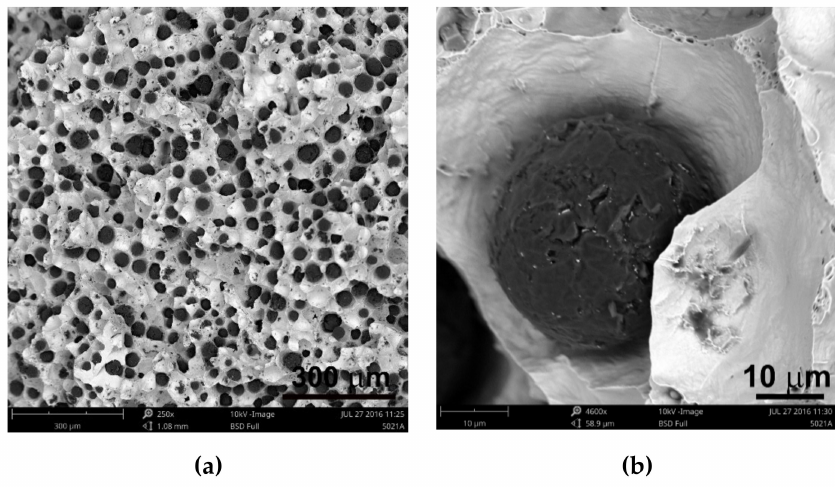
Figure 6. Images of sample fractures 1 magnification 250 × ( a ) and 4600 × ( b ).